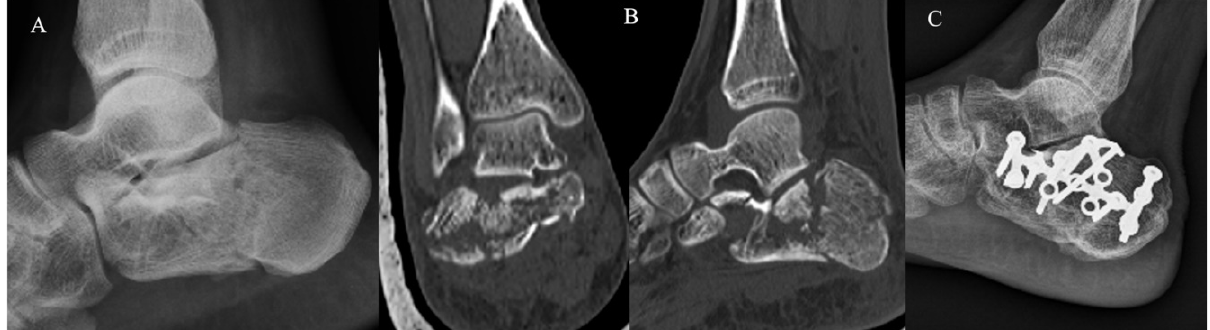
Figure 2. Mini ‐ open approach and K ‐ wire fixation. ( A ) Pre ‐ operative radiographs; ( B ) pre ‐ operative CT scan in coronal and sagittal plane showing a Sanders III CF; ( C ) post ‐ operative radiograph control; ( D ) post ‐ operative radiographs at 4 ‐ year follow ‐ up.